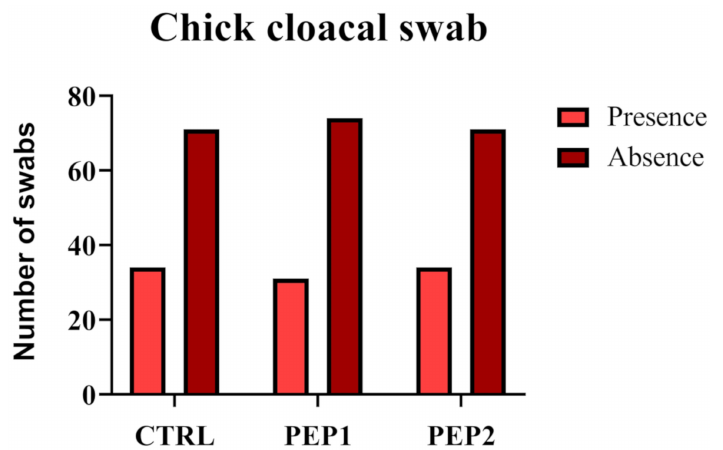
Figure 7. Evaluation of the effect of antimicrobial peptide on Salmonella Enteritidis fecal excretion during 28 days.